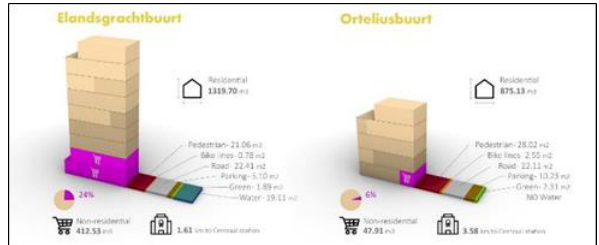
Figure 14. Example of two prototypic buildings used for comparison. Each building represents the living-space values of the corresponding neighbourhood (e.g. Elandsgrachtbuurt and